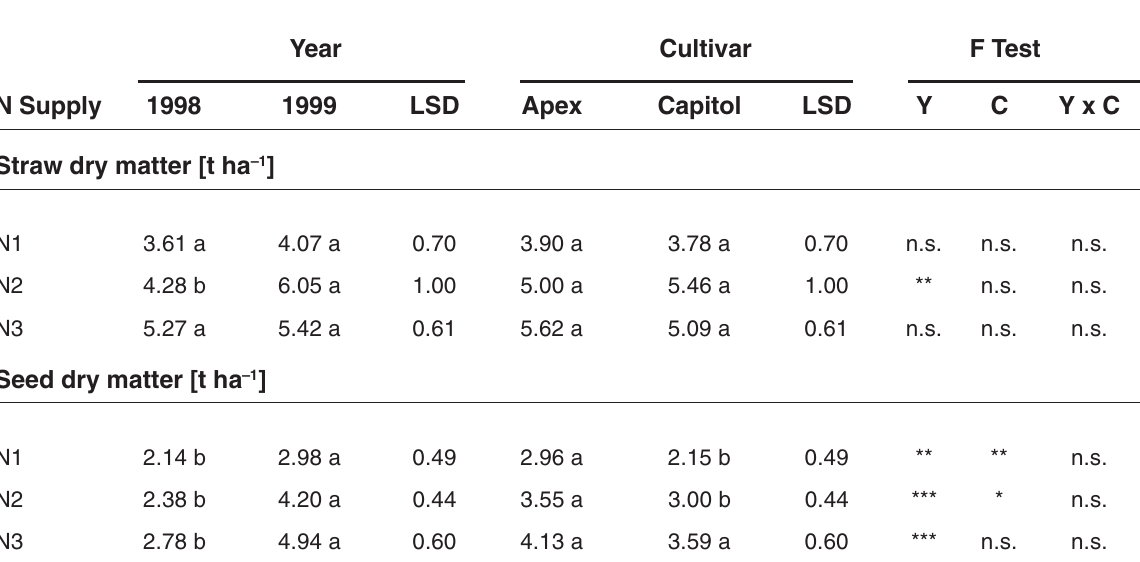
Straw and Seed Dry Matter of Oilseed Rape as Influenced by Year (Y), Cultivar (C), and N Supply